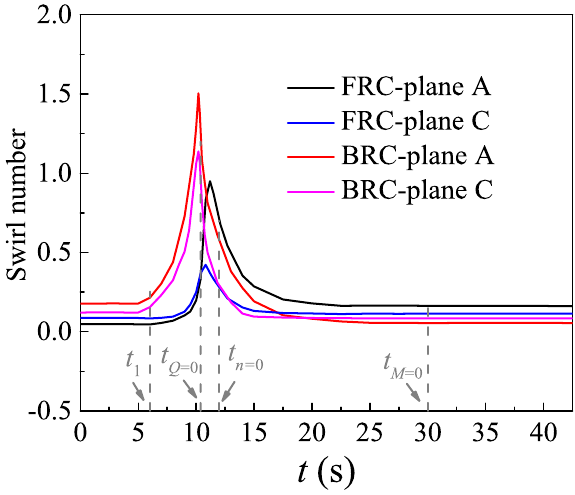
Figure 17. Swirl number of the monitoring planes under FRC and